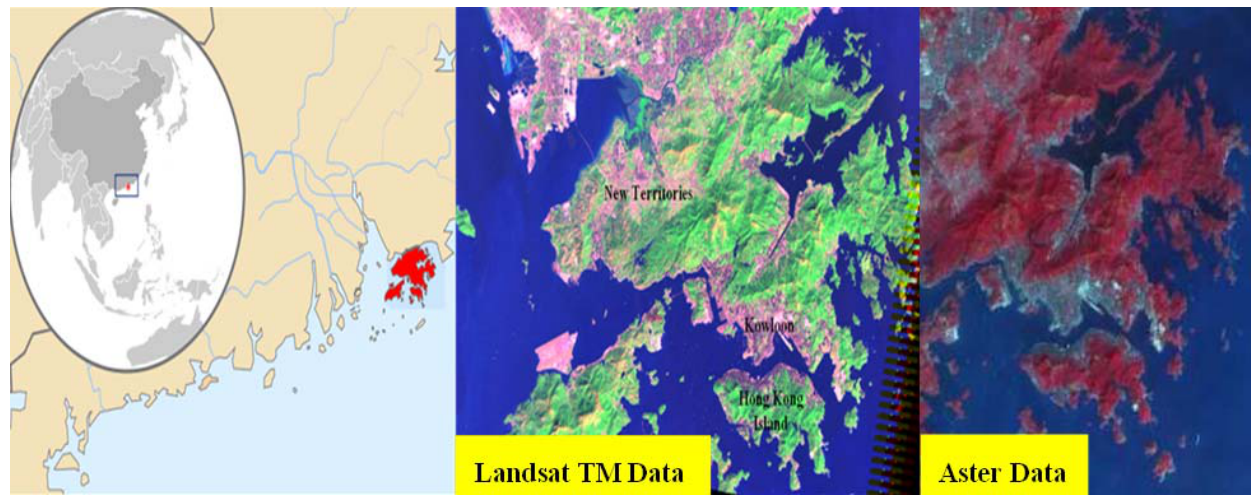
Figure 1. The study area of Hong